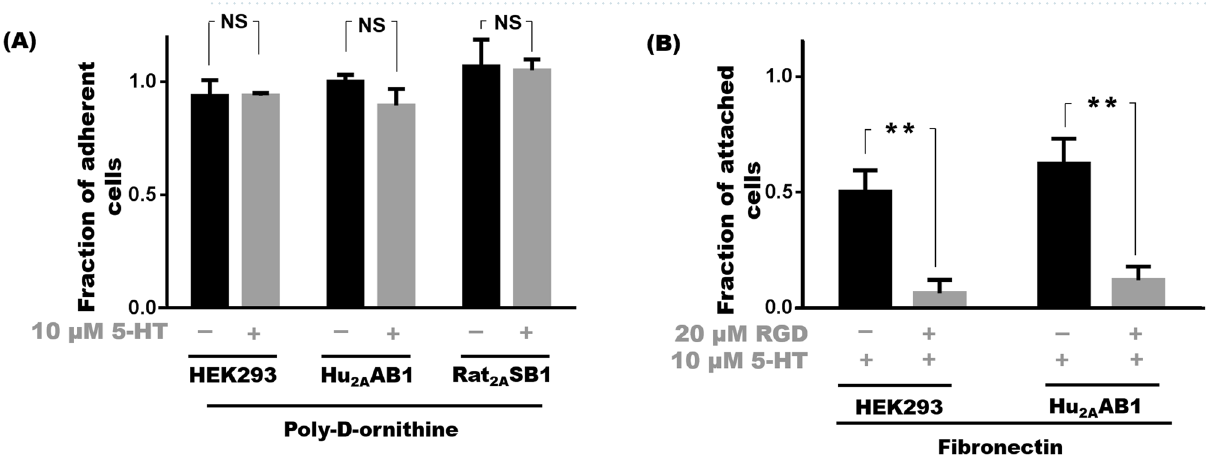
Figure 2. 5-HT 2A -mediated adhesion is specific to natural substrates. ( A ) Cell adhesion profile of HEK293,